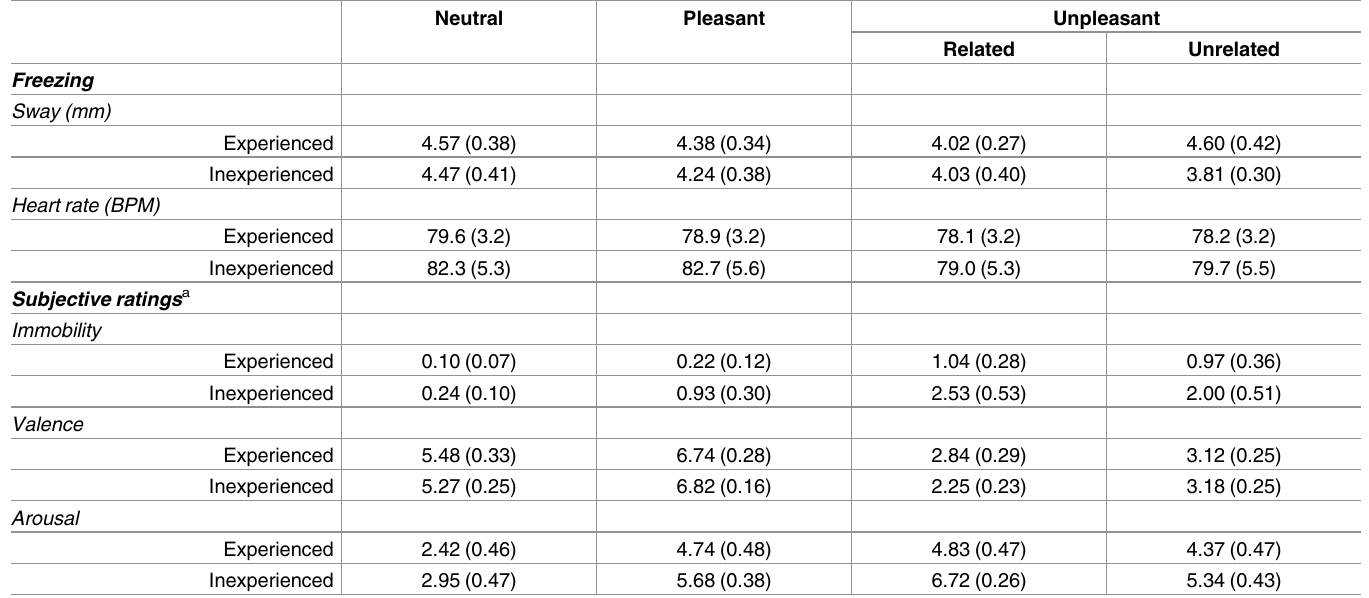
Table 2. Mean and standard error of mean per stimulus category of the freezing measuresand the subjective ratings presented for the experi- enced ( n = 19) and inexperienced ( n = 16) group